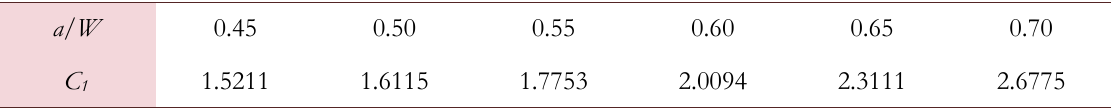
Table 1: Values of C 1 computed from Eq.(5).